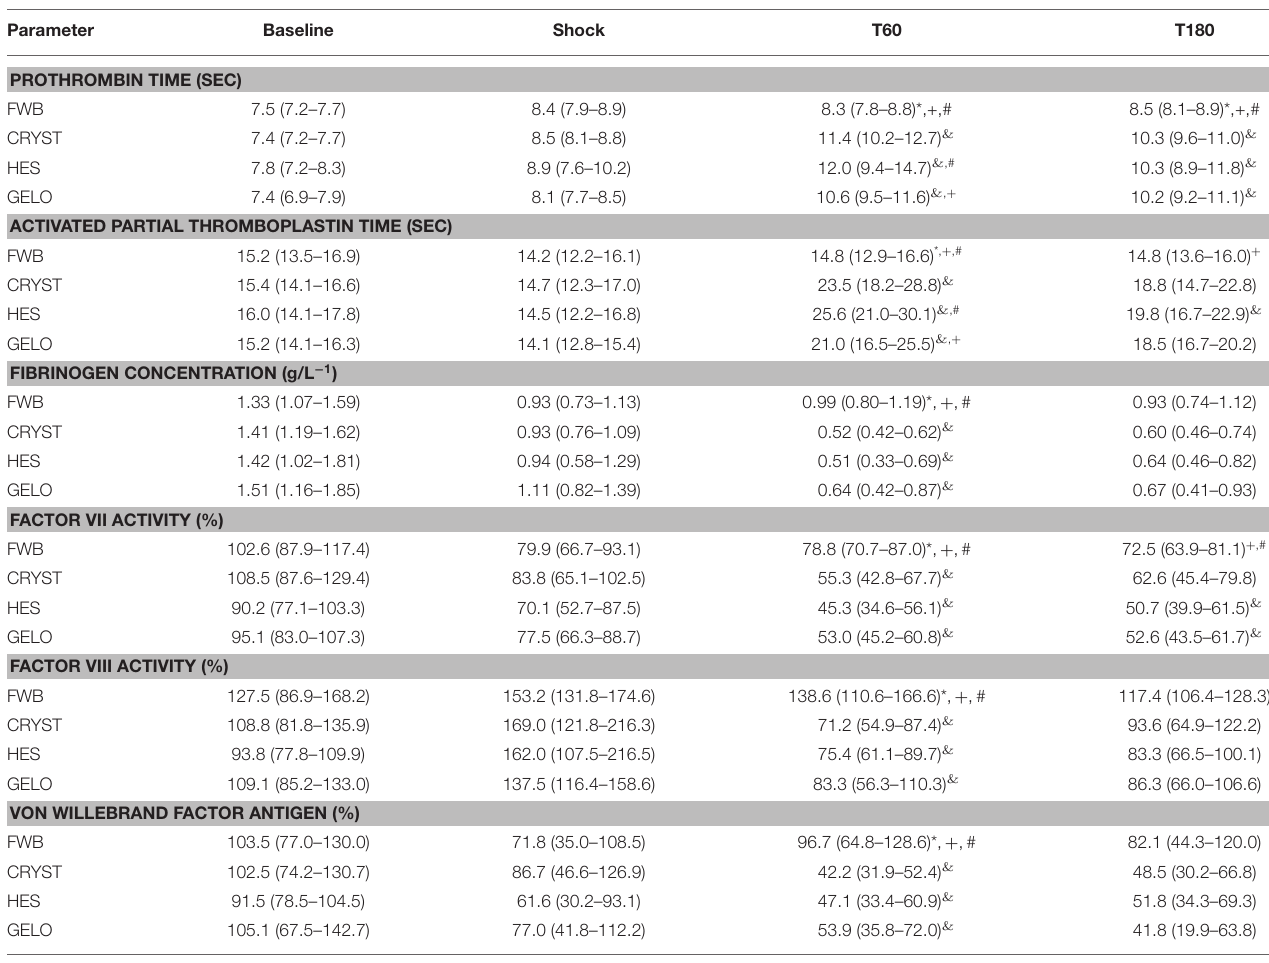
TABLE 4 | Plasma coagulation assay parameters (mean, 95% confidence interval) in dogs ( n = 6 per group) with hemorrhagic shock given 20mL kg − 1 of either fresh whole blood (FWB), hydroxyethyl starch 130/0.4 (HES), 4% succinylated gelatin (GELO), or 80mL kg − 1 of balanced isotonic crystalloid (CRYST).